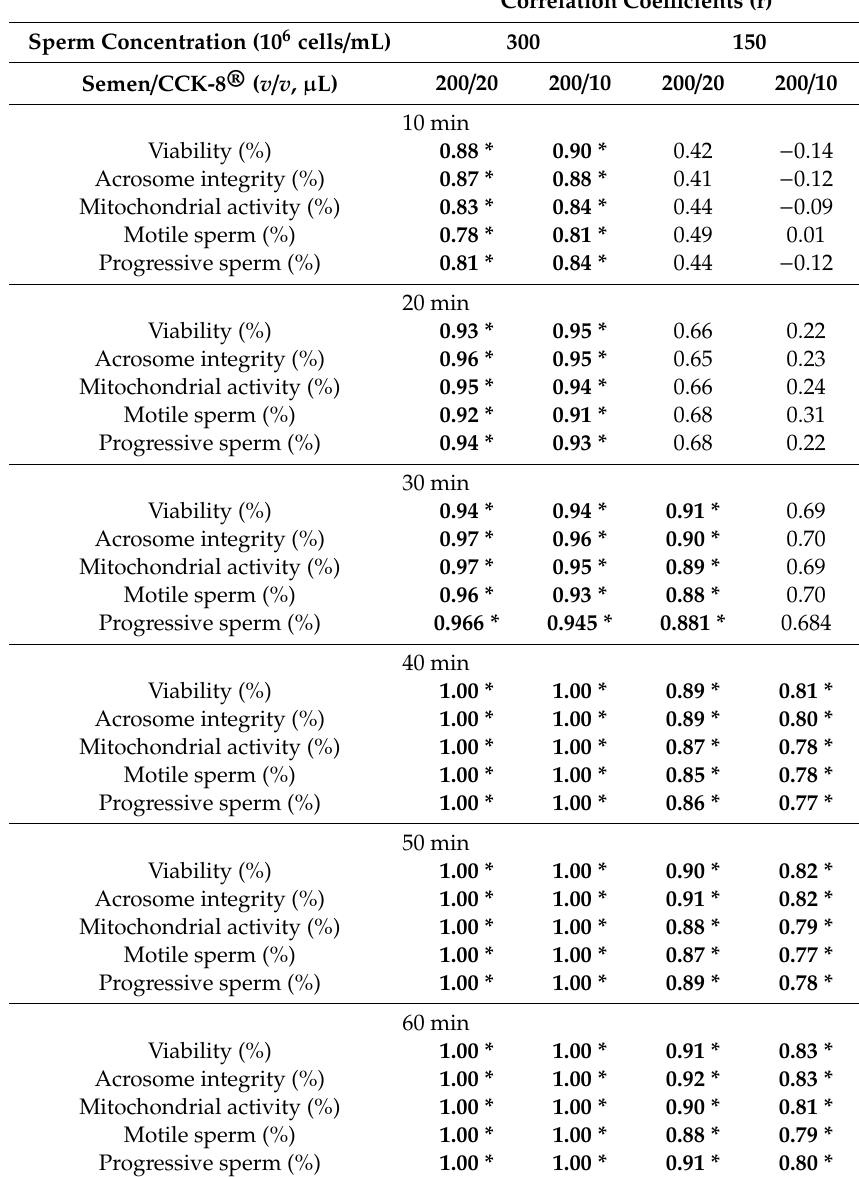
Table 3. Pearson’s correlation coe ffi cients between the WST-8 reduction rate and boar sperm parameters in di ff erent ratios of semen / cell-counting kit-8 (CCK-8 ® ) solution mixtures ( v / v